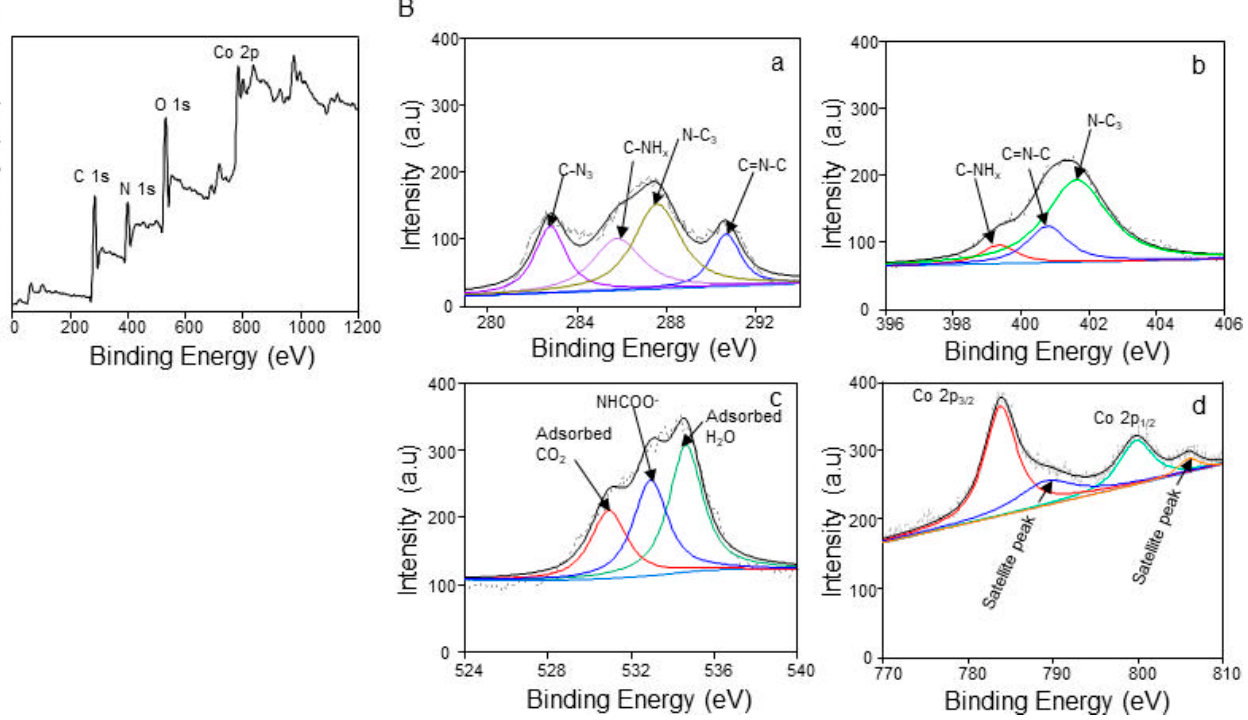
Figure 2. ( A ) A survey XPS and ( B ) deconvoluted fine spectra of ( a ) C 1s, ( b ) N 1s, ( c ) O 1s, and ( d ) Co 2p of Co(11)@g-CN. ( d ) Co 2p of